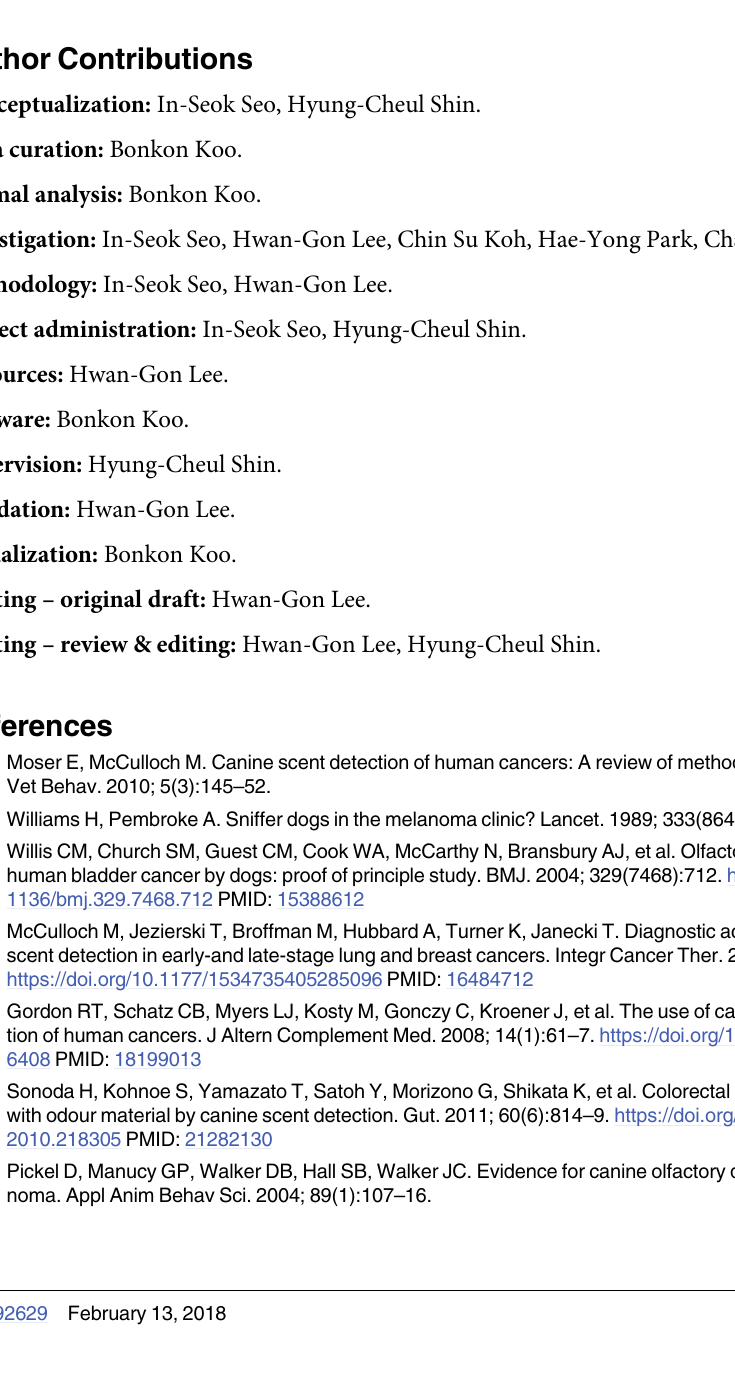
S1 Table. Detection accuracy for the test cancer